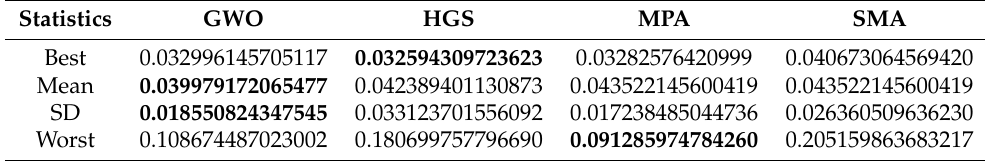
Table 9. Experimental result of RMSE with 100 individuals, 40 evolutions and 30